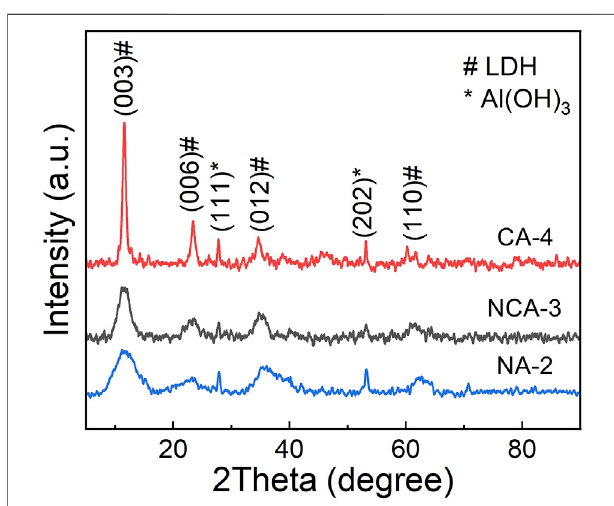
FIGURE 6 | Long-term cycling stability determined a current density of 3 A g − 1 for the control, NA-1, and NA-2 samples. FIGURE 7 | XRD patterns of the NA-2, NCA-3, and CA-4